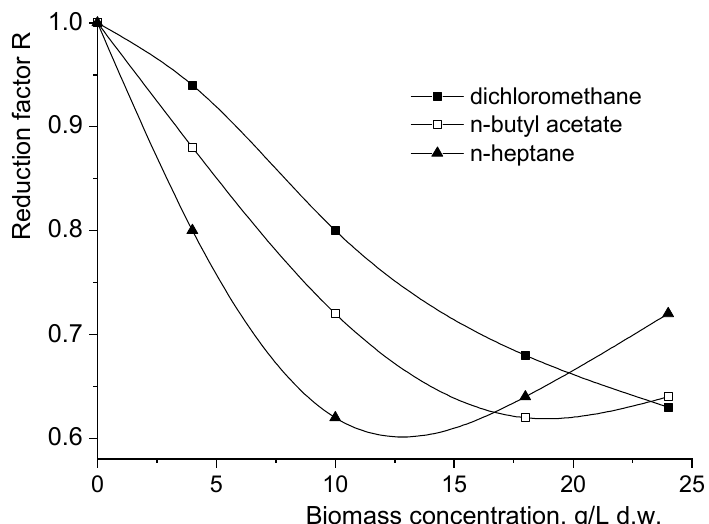
Figure 4. Influence of Rhizopus oryzae concentration on the reduction factor for the organic phase without 1-octanol (rotation speed = 1000 rpm).